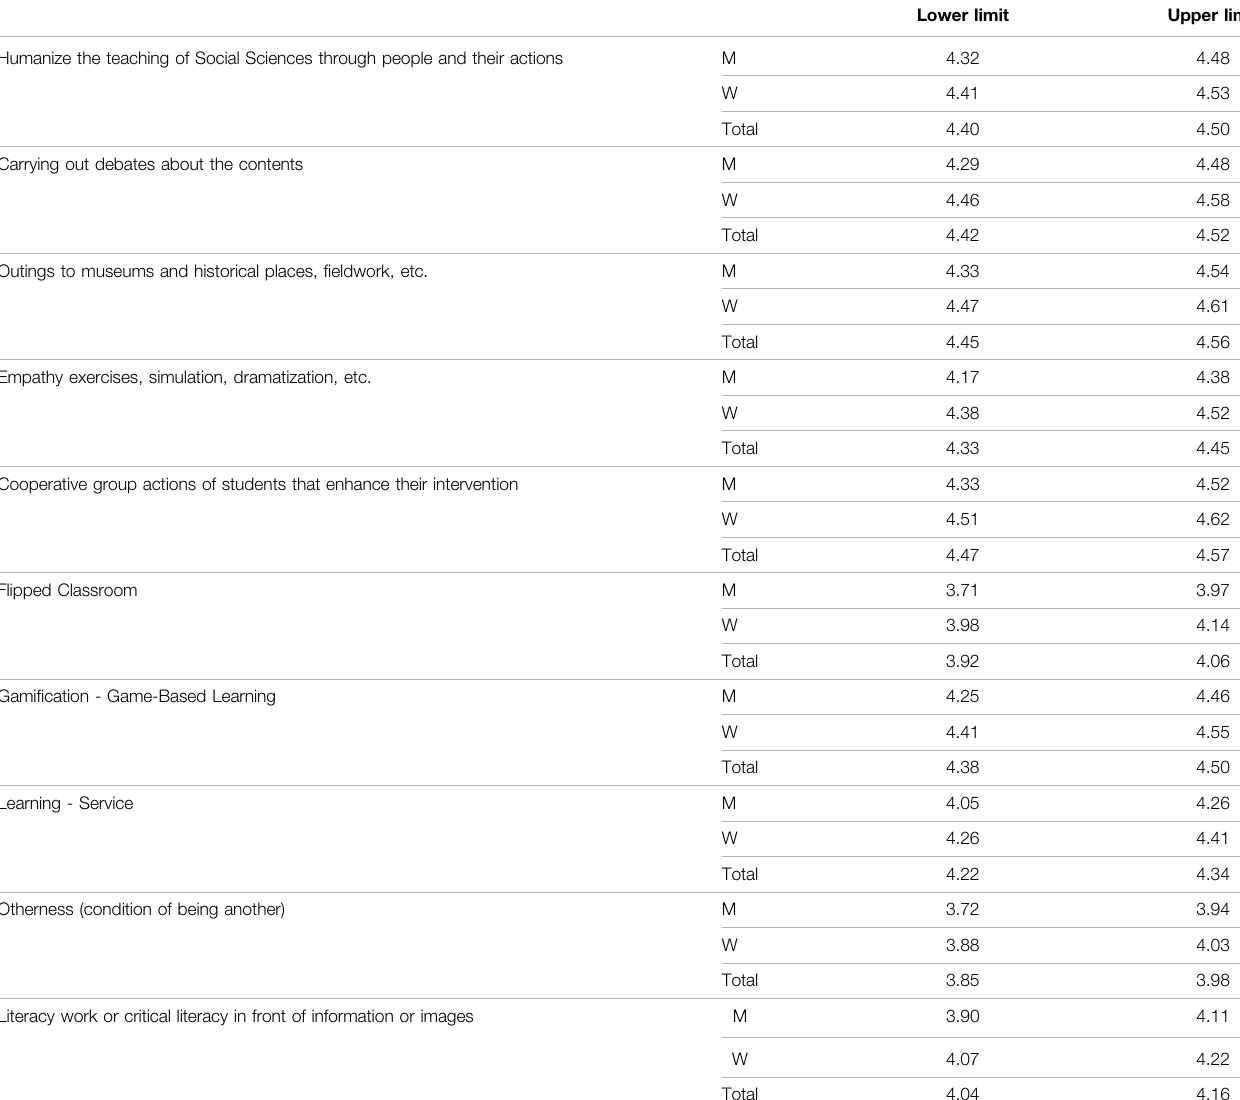
TABLE 7 | Descriptive analysis of the teaching methods, according to